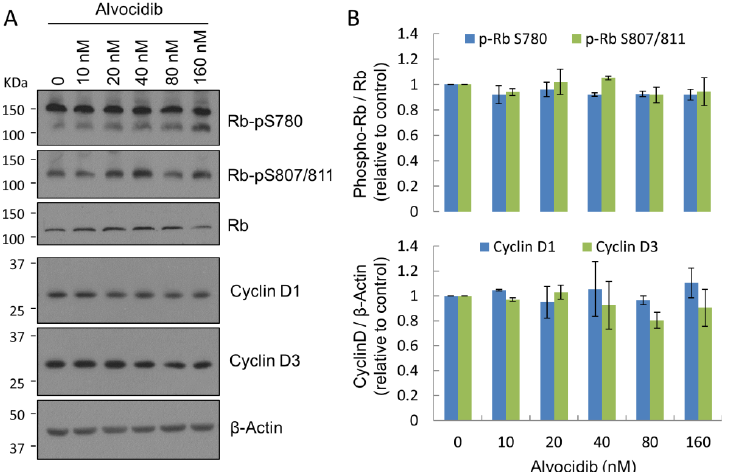
Figure 3. ( A ) Alvocidib effect on Rb phosphorylation and protein levels of cyclin D1/D3. HEK293T cells treated with DMSO or increasing concentrations of Alvocidib. Equal amounts of total proteins from cell lysates were Western blotted for total Rb, phospho ‐ Rb, and cyclin D1 and D3 signals. ( B ) Phospho-Rb signals were normalized against total Rb and Cyclin D1 and D3 signals were normalized against β -Actin. Shown is average ± SD, n = 3; Student t -test, not significant. 2.4. Alvocidib Modulates Cilia Length via CILK1 Inhibition CILK1 is a negative regulator of cilia length, and we tested if Alvocidib inhibition of CILK1 would induce cilia elongation. We used mouse embryonic fibroblast (MEF) cell lines that express either wild type (WT) CILK1 or the R272Q mutant form. Our prior work has shown that the R272Q mutation in CILK1 eliminates kinase activity and there is cilia elongation in MEFs expressing this CILK1 inactive mutant [16]. We treated MEF cell lines expressing either WT or the R272Q mutant with Alvocidib (100 nM, IC 90 ) or DMSO (solvent control) for 4 h and then fixed and immunostained cells with cilia marker Arl13B and basal body marker γ‐ tubulin (Figure 4A). We measured cilia length in Z stacks of confocal immunofluorescence images (Figure 4B). In WT MEF cells, Alvocidib treatment induced a 20% increase in cilia length (Figure 4B). However, in cells expressing the CILK1 R272Q mutant, Alvocidib did not induce any statistically significant increase in cilia length (Figure 4B). We thus concluded that Alvocidib stimulates the elongation of primary cilia, and this response is dependent on the inhibition of CILK1.